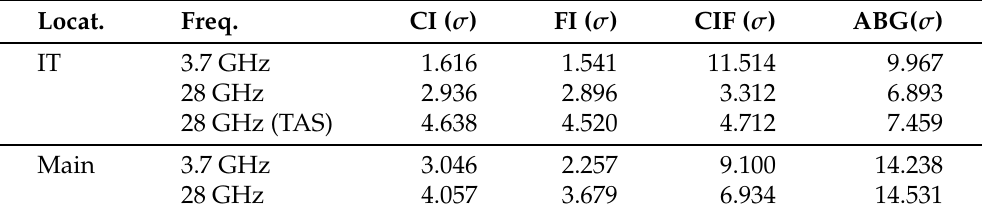
Table 5. Shadow factor of the CI, CIF, FI, and ABG models obtained through the MMSE technique.